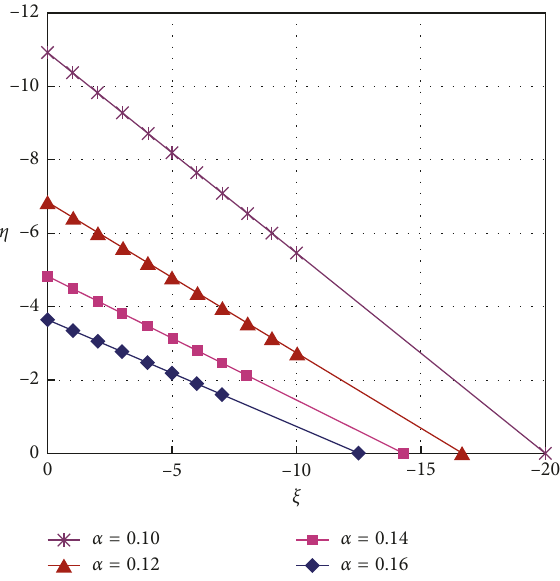
Figure 3: Plastic limit load envelopes of the shaft lining consid- ering the SD effect.